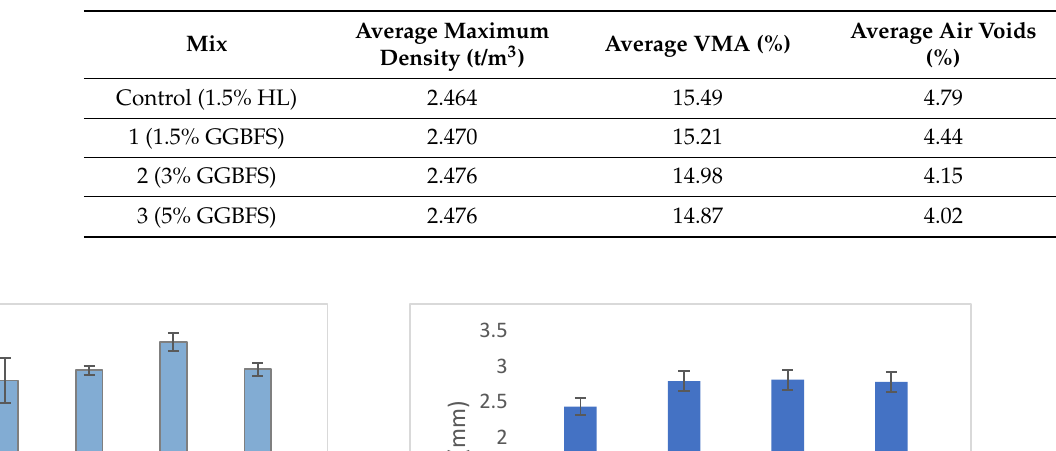
Table 9. Volumetric characteristics of the mixtures.